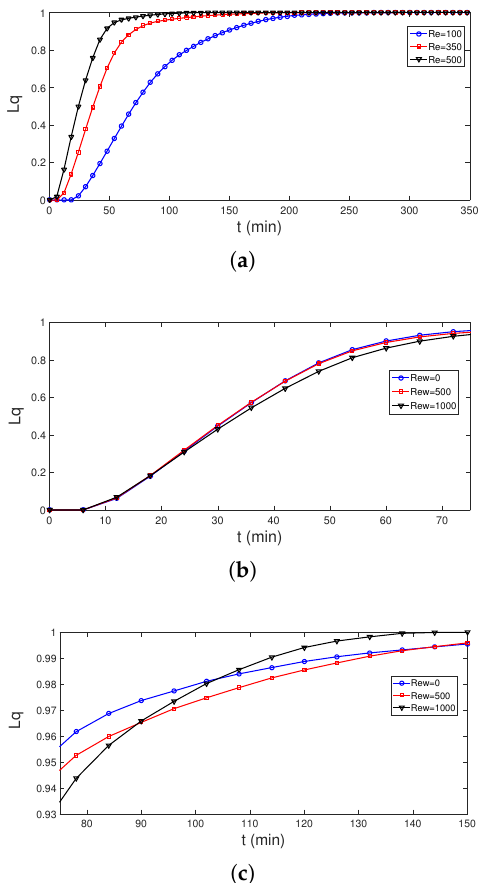
Figure 7. Time evolution of average Lq with varying Re (( a ) Rew = 500) and varying Rew (( b , c ) Re = 300) ( di = 0.25 L 1, L 0 = 0.6 L 1, yp = 0.1 H, and NC = 0.02).